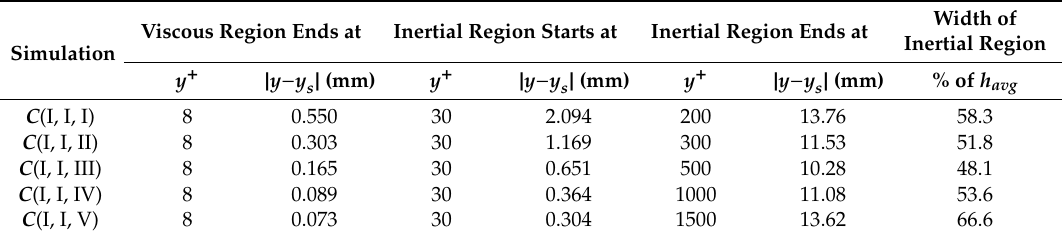
Figure 14. Log-law profiles on bottom wall with respect to parameters. Data plotted at ( a ): x λ = 0 and ( b ): x λ = 0.5. Table 4. Boundary layer details near for Re